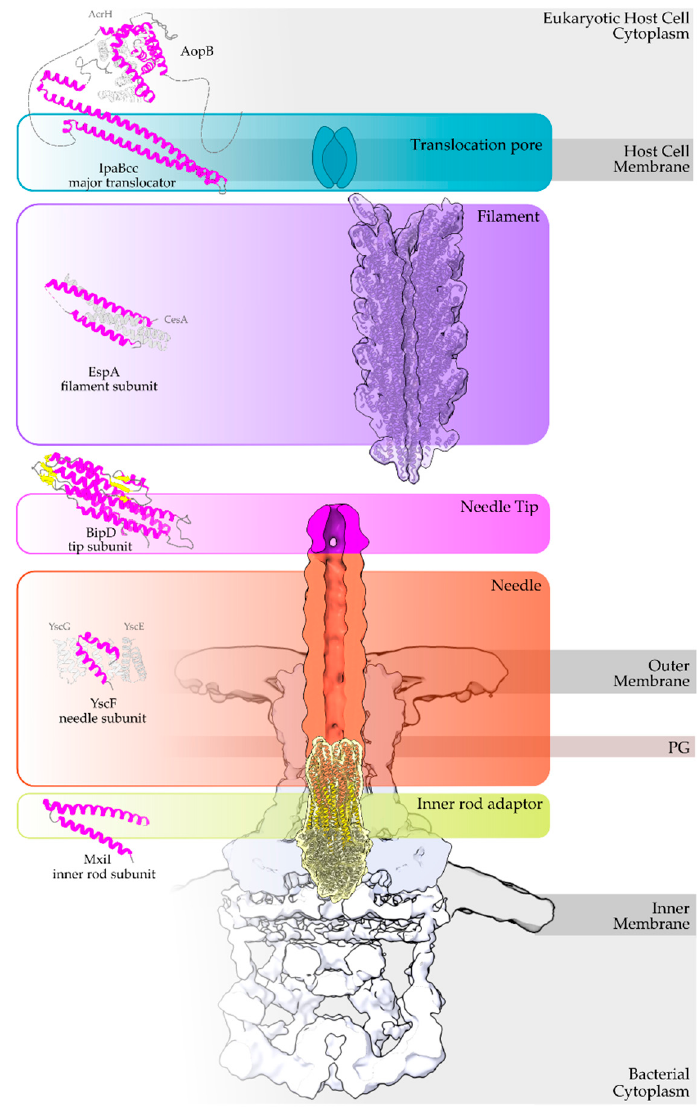
Figure 1. Overview of a T3S nanomachine embedded in the two bacterial membranes. Early and middle secretion substrates are almost all α -helical. The early secretion substrates build the inner